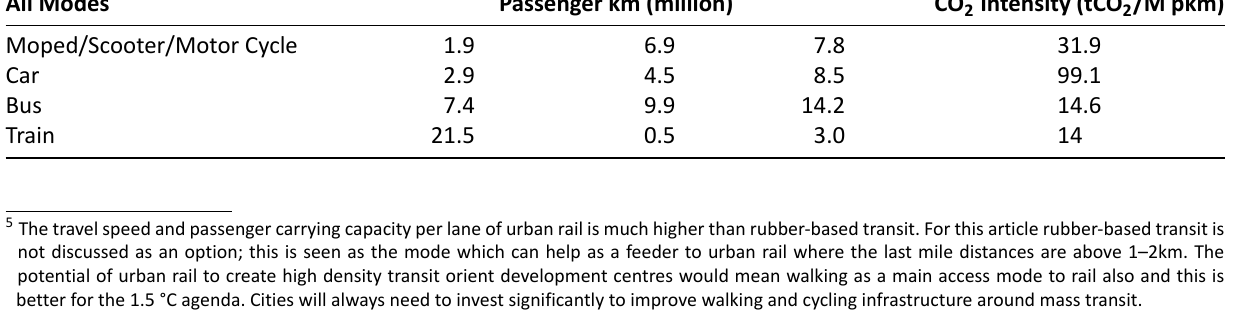
Table 1. Passenger km and CO